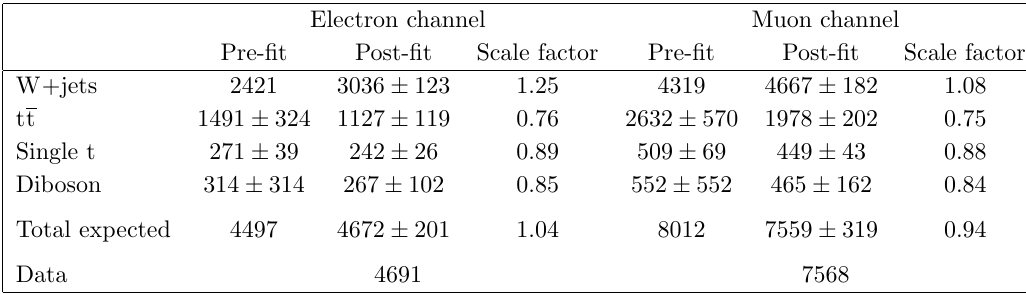
Table 1 . Results of the signal extraction (cid:12)ts. The uncertainties in the pre-(cid:12)t yields are their respective pre-(cid:12)t constraints, whilst the uncertainties in the post-(cid:12)t yields are the corresponding total post-(cid:12)t uncertainties. Since the normalization of the W+jets contribution is allowed to vary freely in the (cid:12)t, it does not have any corresponding pre-(cid:12)t